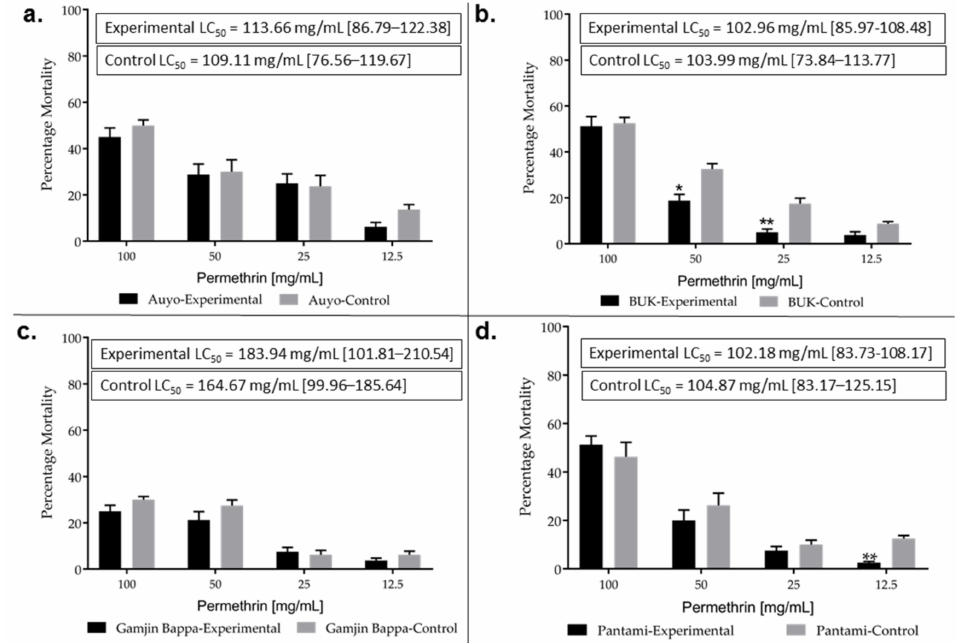
Figure 2. Resistance profiles of Anopheles gambiae s.l. larvae. Results of WHO larval bioassay with permethrin, for ( a ). Auyo, ( b ). BUK, ( c ). Gamjin Bappa and ( d ). Pantami. * and ** = statistically significant at p < 0.05 and p < 0.01, respectively from two tailed χ 2 square test of independence. LC 50 for experimental and control larvae for each of the 4 sites are provided in rectangular inset with 95% confidence limits.